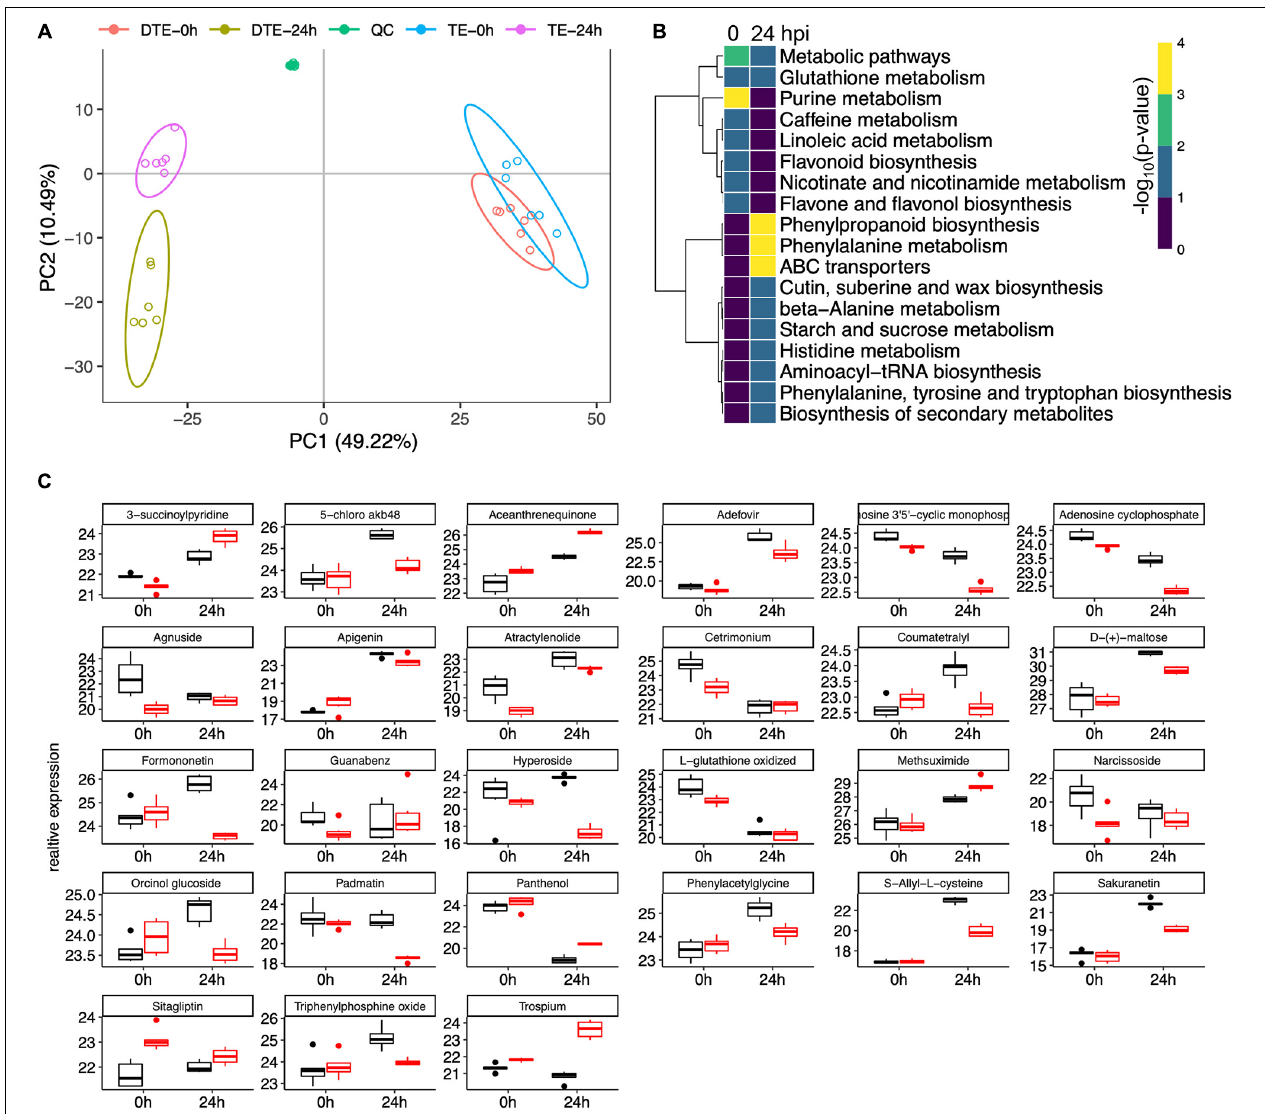
FIGURE 9 | Metabolomic analysis revealed key pathways associated with early-stage resistance to gibberella stalk rot (GSR). (A) Principal component analysis to determine the global metabolic variation between Y331- (cid:49) TE and Y331 at 0 and 24 hpi. (B) Heatmap showing the significance of metabolic pathways enriched by metabolic compounds detected in comparative metabolomics comparing Y331- (cid:49) TE and Y331. (C) Boxplots showing the relative abundance of detected metabolic compounds in comparative metabolomics which are significantly altered between Y331- (cid:49) TE and Y331. Black refers to Y331, and red refers to